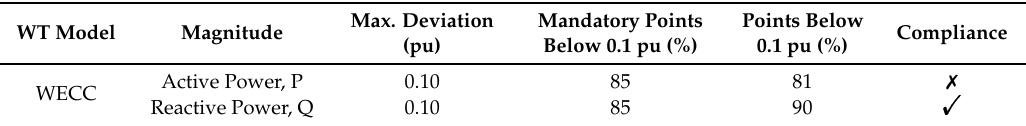
Table 2. Verification of the PVVC validation criteria applied to the WECC WT model at the low-voltage (LV) measurement point, operating at full load conditions: 690